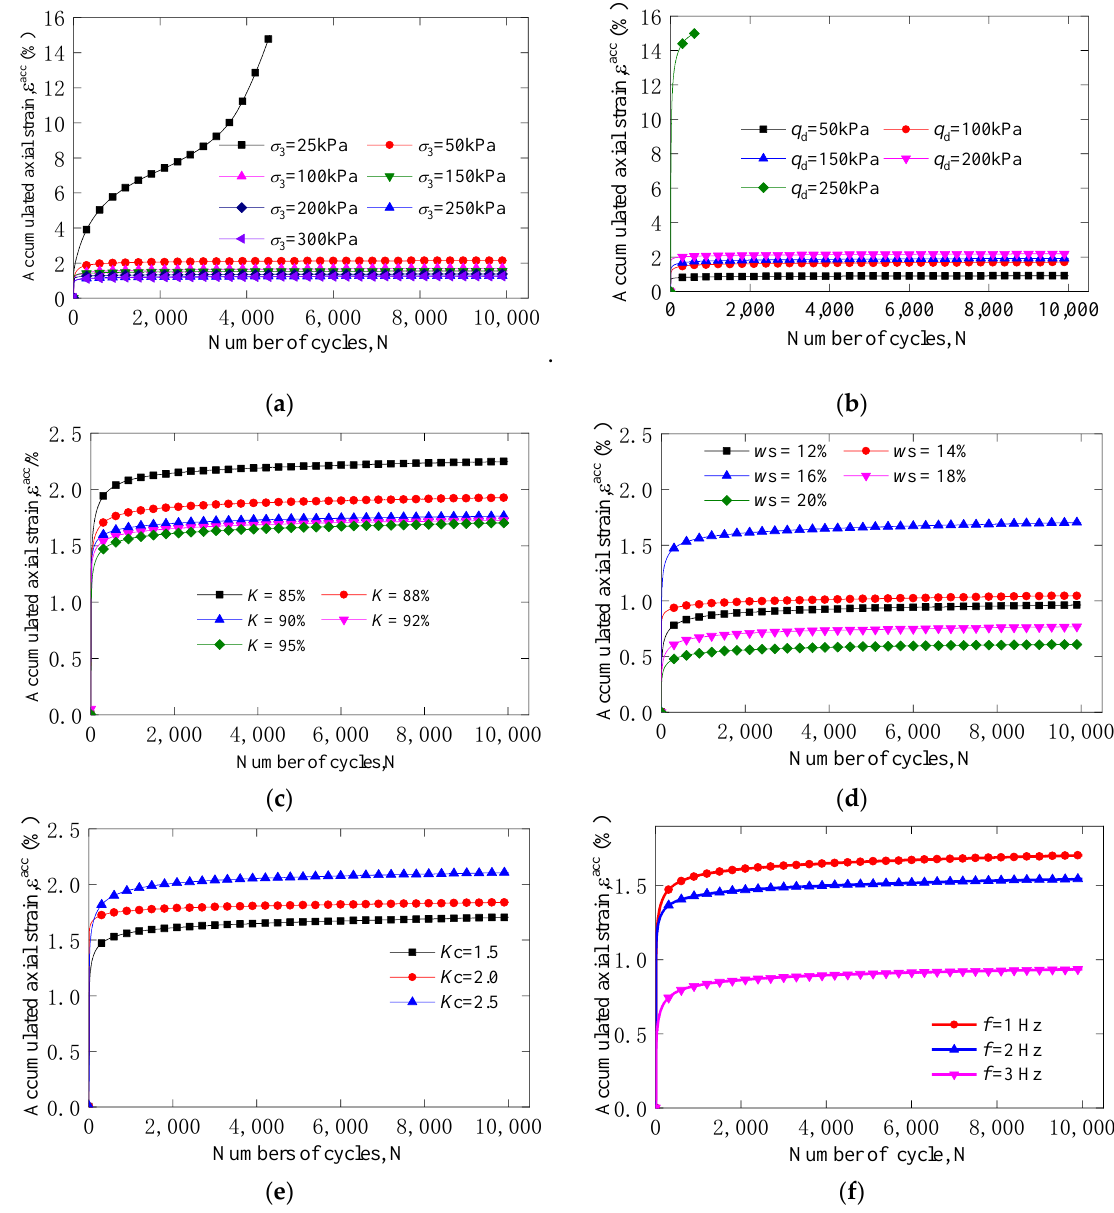
Figure 4. Accumulated axial strain under different test conditions. ( a ) Accumulated axial strain versus number of loading cycles under different confining pressures. ( b ) Accumulated axial strain versus number of loading cycles under different loading amplitudes. ( c ) Accumulated axial strain versus number of loading cycles under different K c ( d ) Accumulated axial strain versus number of loading cycles under different loading frequencies. ( e ) Accumulated axial strain versus number of loading cycles under different densities, K . ( f ) Accumulated axial strain versus number of loading cycle under different moisture content.